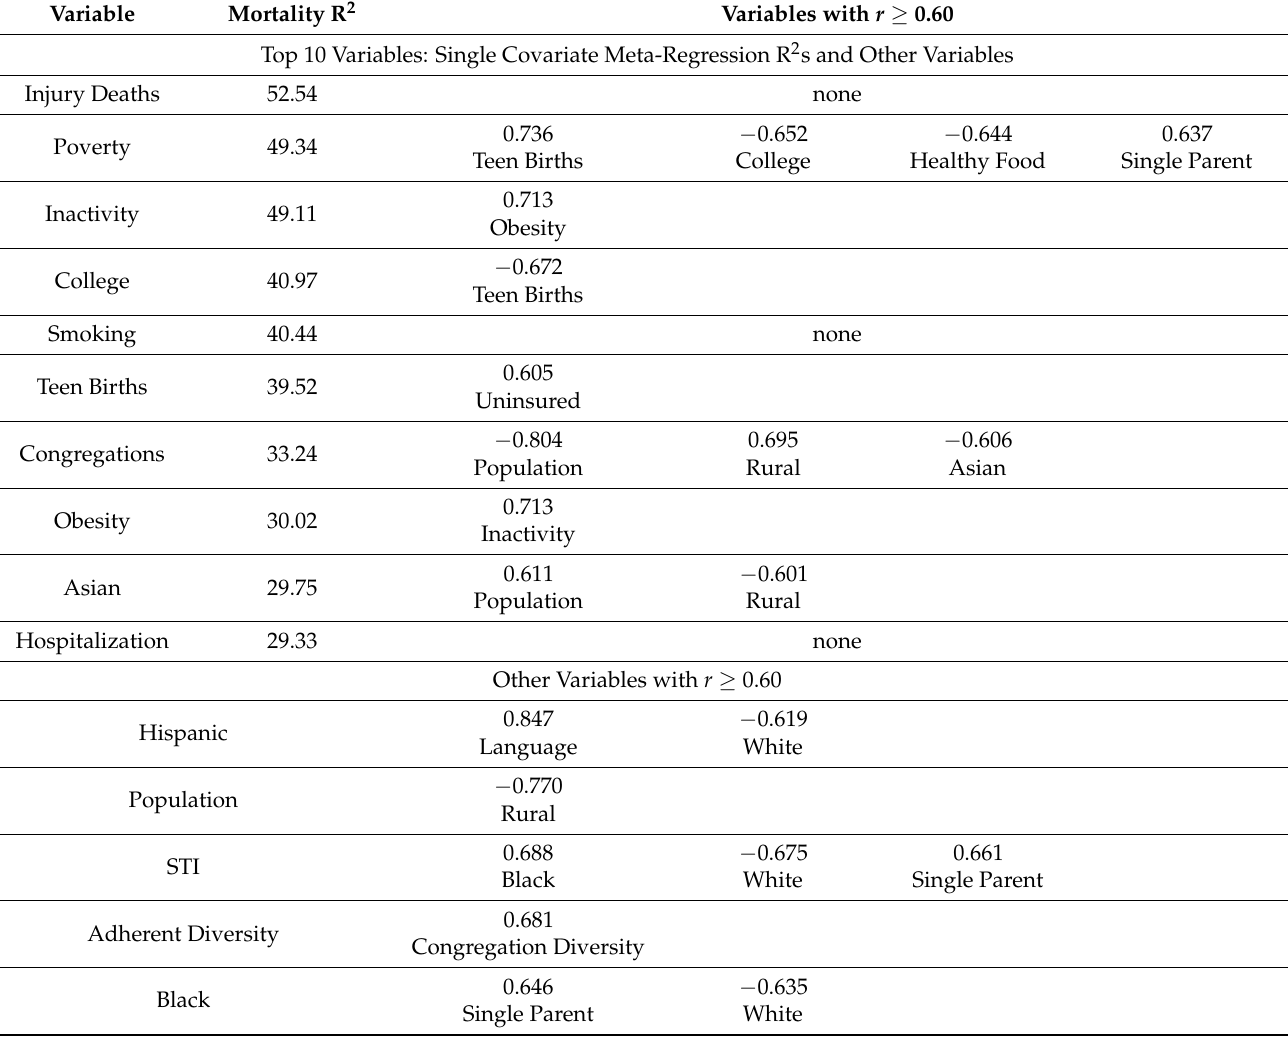
Table 2. Substantial Correlations ( r ≥ 0.60).